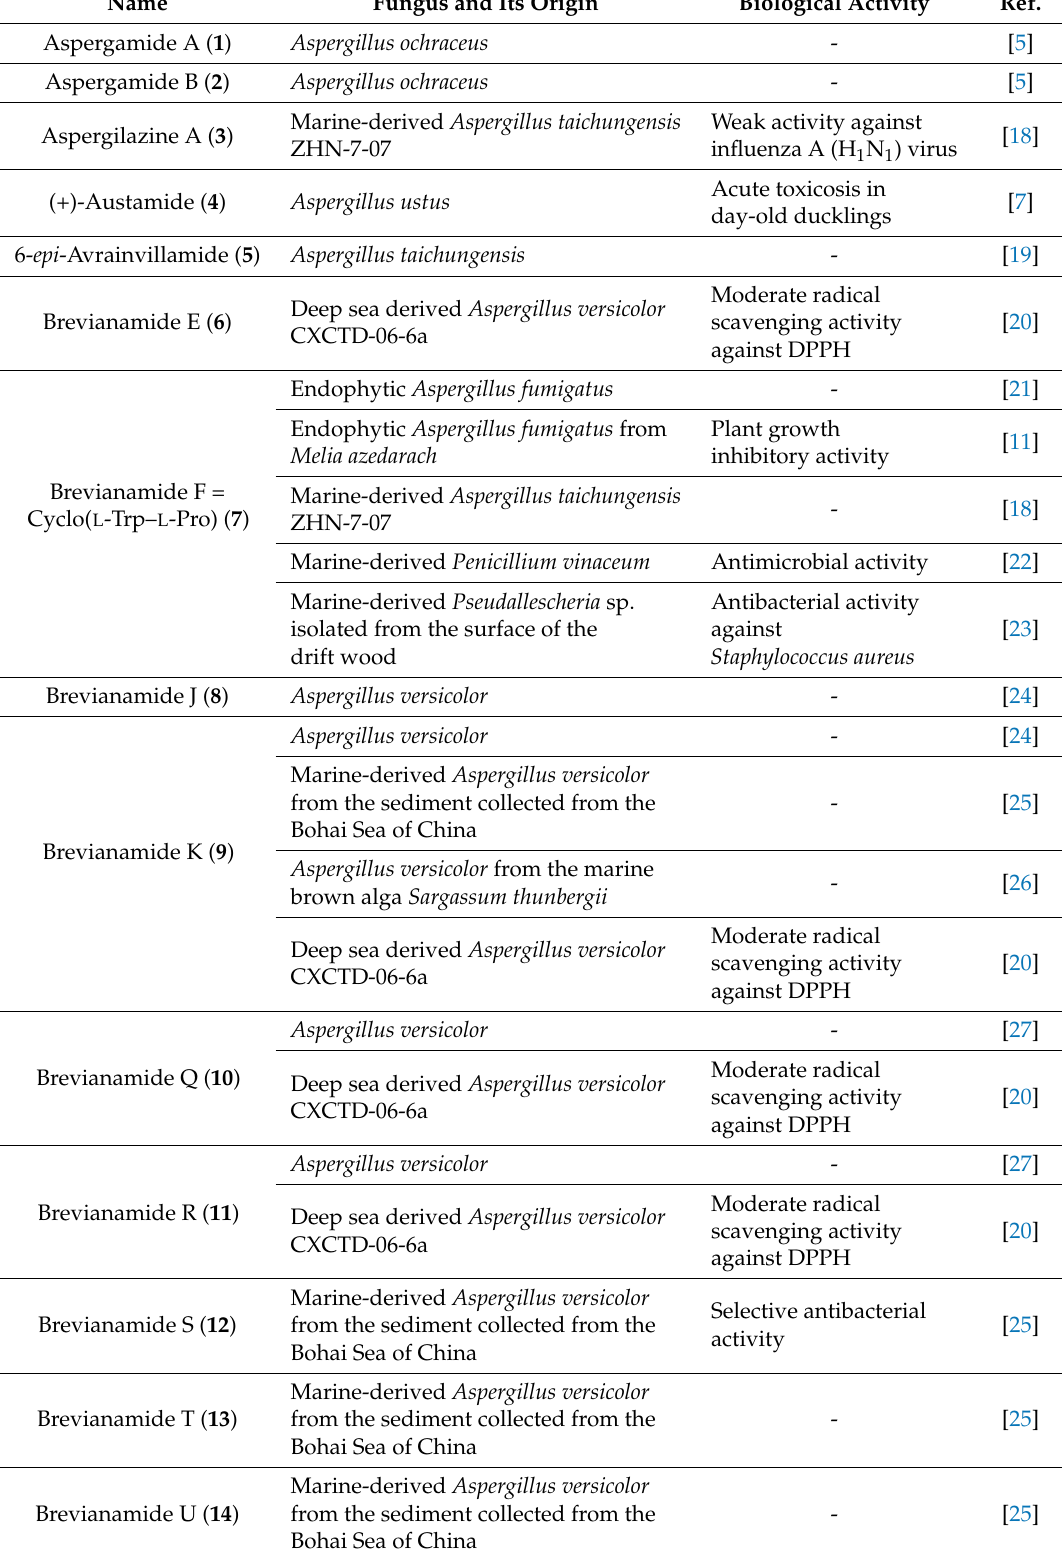
Table 1. Fungal tryptophan-proline cyclodipeptide analogs and their biological